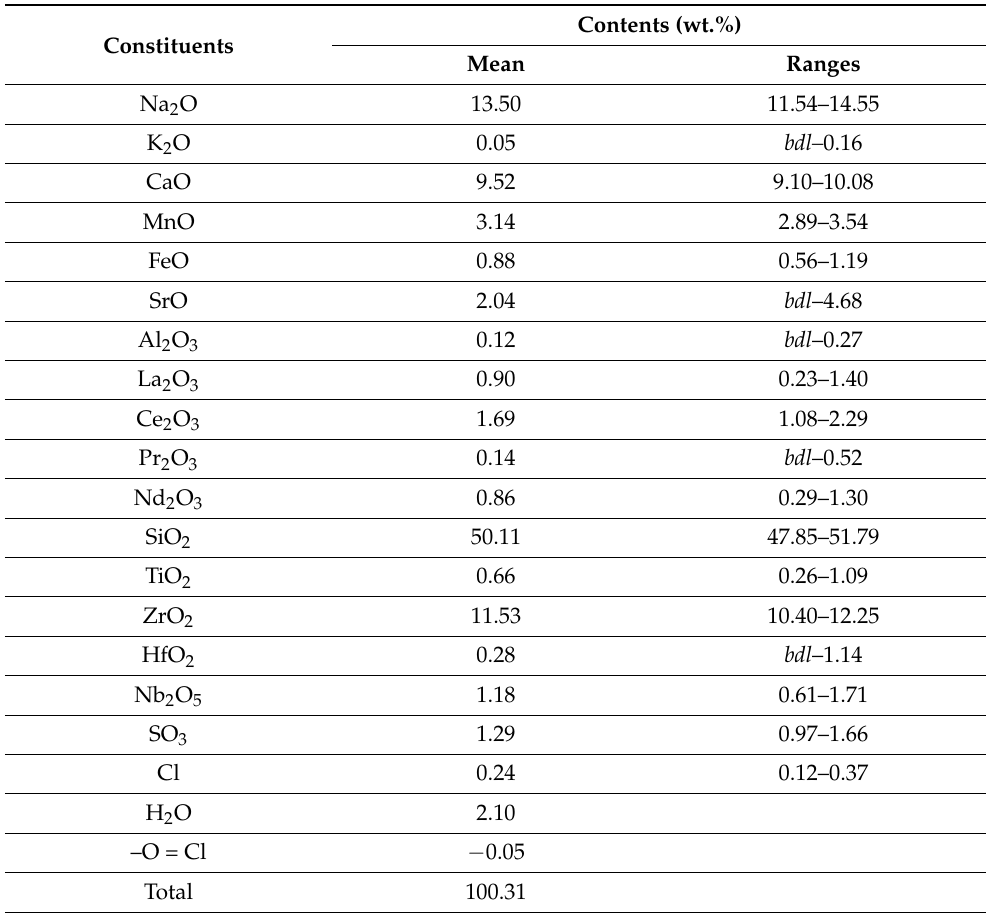
Table 1. Chemical composition of the studied sample.